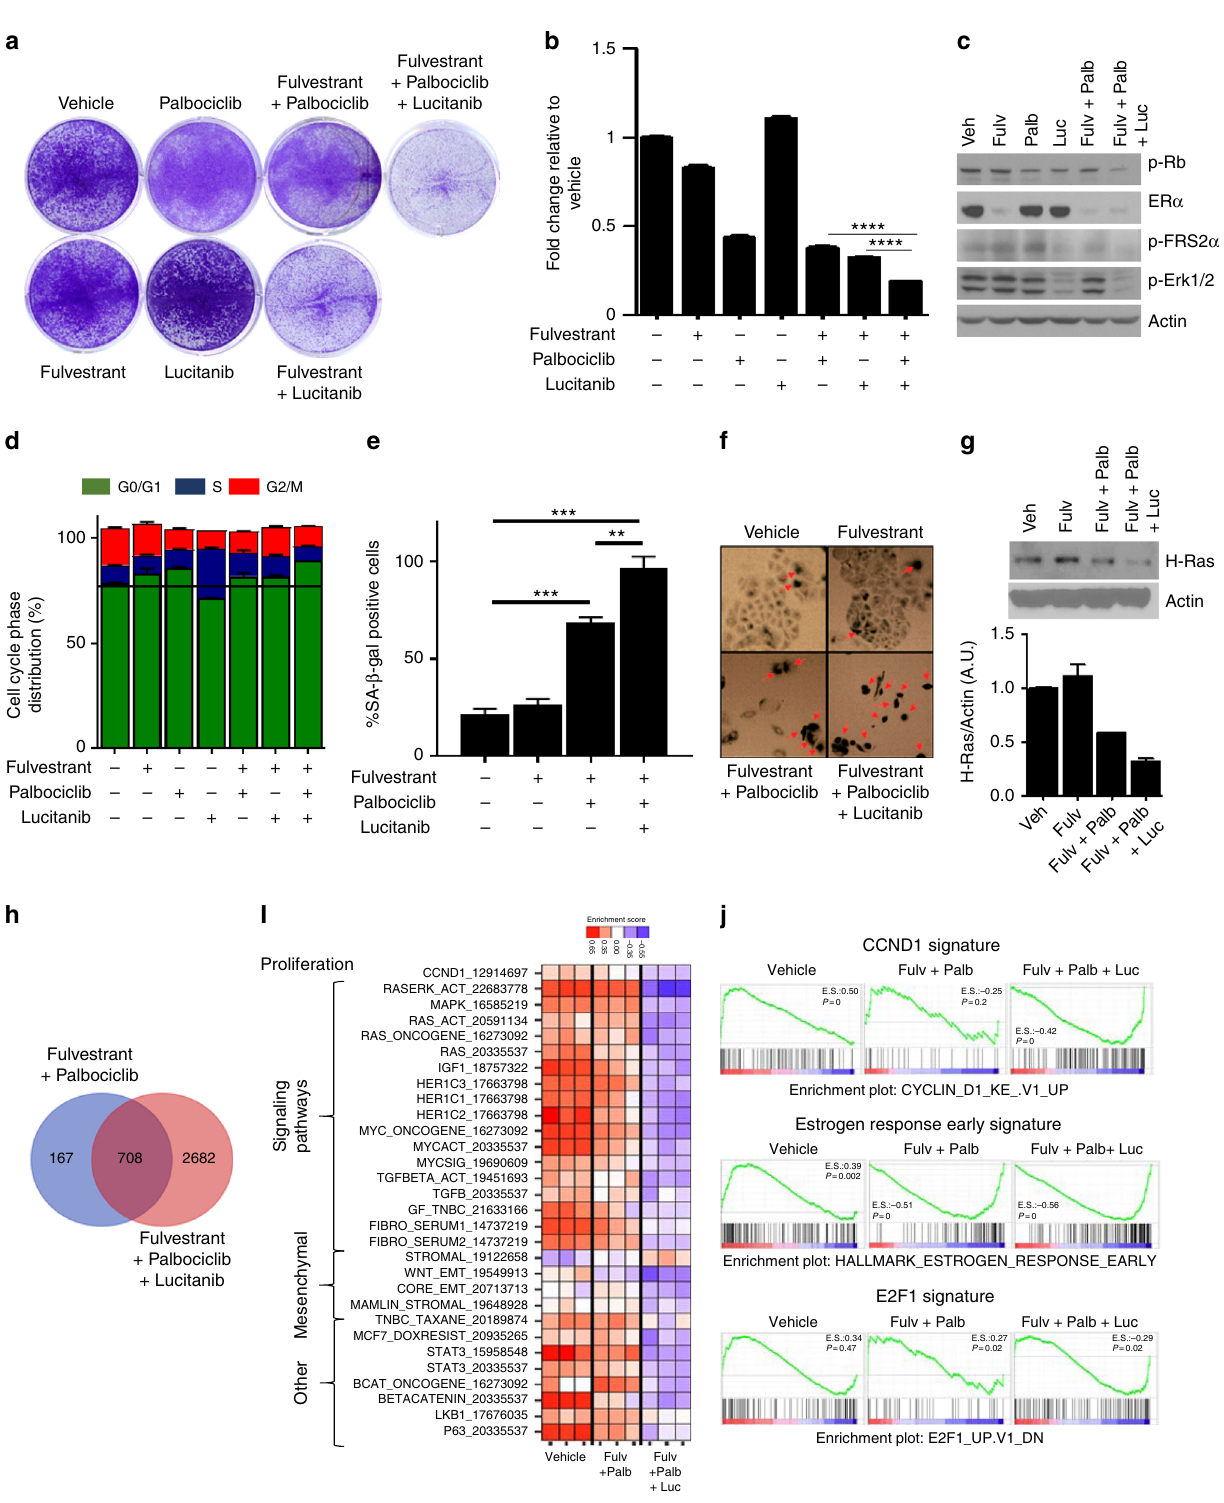
suggesting that the ER also plays a role in CAMA1 cell viability (Supplementary Figure 8A, B). In estrogen-depleted medium, however, transfection of cyclin D1 siRNA blocked the growth of CAMA1 cells to the same degree as FGFR1 knockdown (Supplementary Figure 8C). Immunoblot analysis showed that FGFR1 knockdown reduced cyclin D1 and pRB levels, similar to the knockdown of cyclin D1 (Supplementary Figure